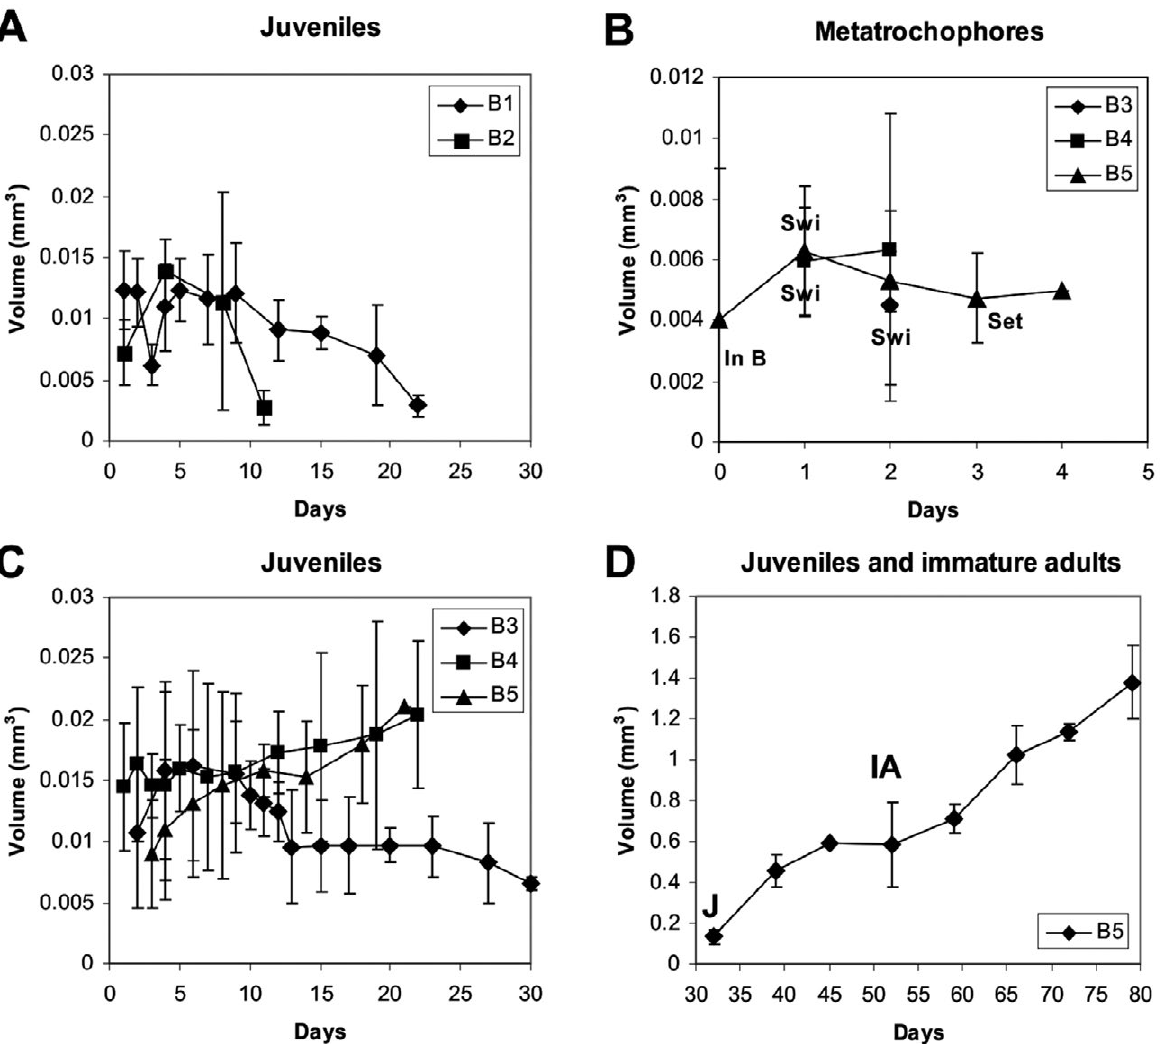
Fig. 1. – Average volume±SD of individuals of Capitella sp. A over time during the experimental series 1. A, juveniles reared in the “natural sediment” treatment 1b (broods 1 and 2); B, metatrochophores in the “organically enriched sediment” treatment 1a (broods 3 to 5); C, juveniles in the “organically enriched sediment” treatment 1a (broods 3 to 5); D, juveniles and immature adults in the “organically enriched sediment” treatment 1a (brood 5) (In B, metatrochophores inside broods; Swi, swimming metatrochophores; Set, settling metatrochophores; J, juveniles; IA, immature